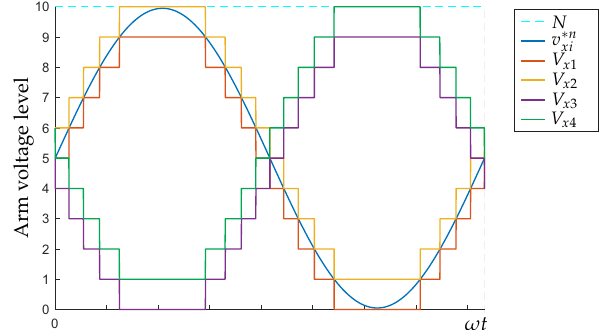
Figure 6. Corresponding voltage levels for v ∗ n